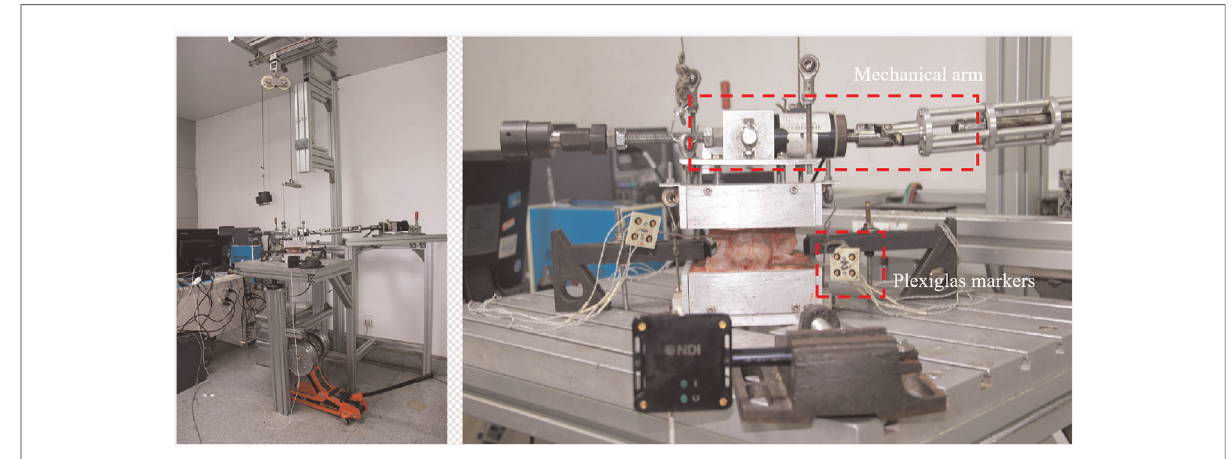
FIGURE 4 Composition of the mechanical test system and installation of